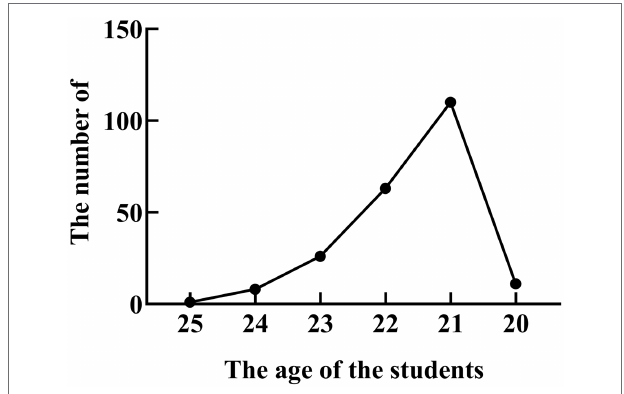
FIGURE 3 | The age statistics of college students who participated in the questionnaire.